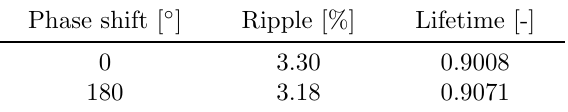
Table 14: Effect of pump phase shift on ripples and